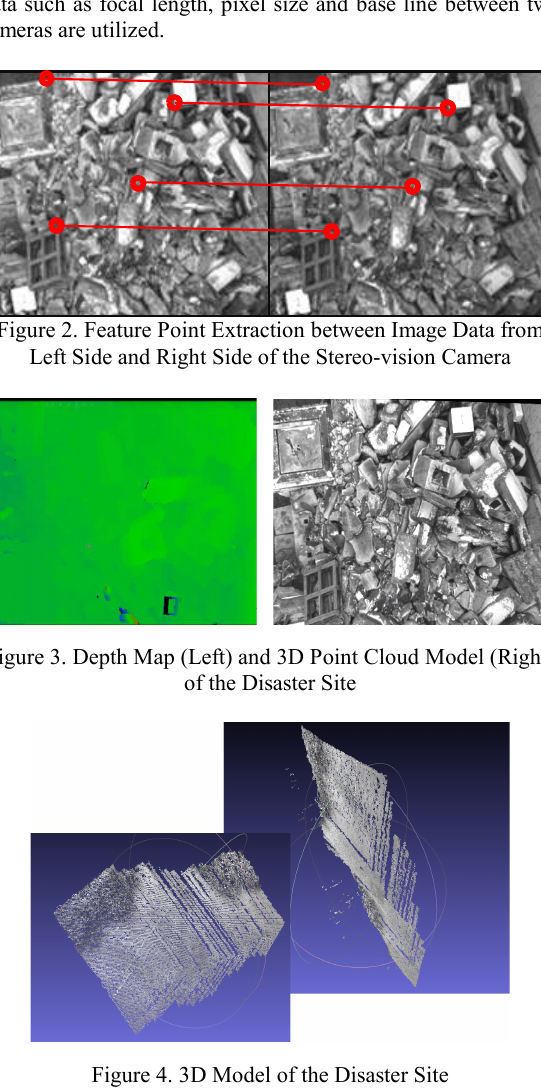
Figure 4. 3D Model of the Disaster Site